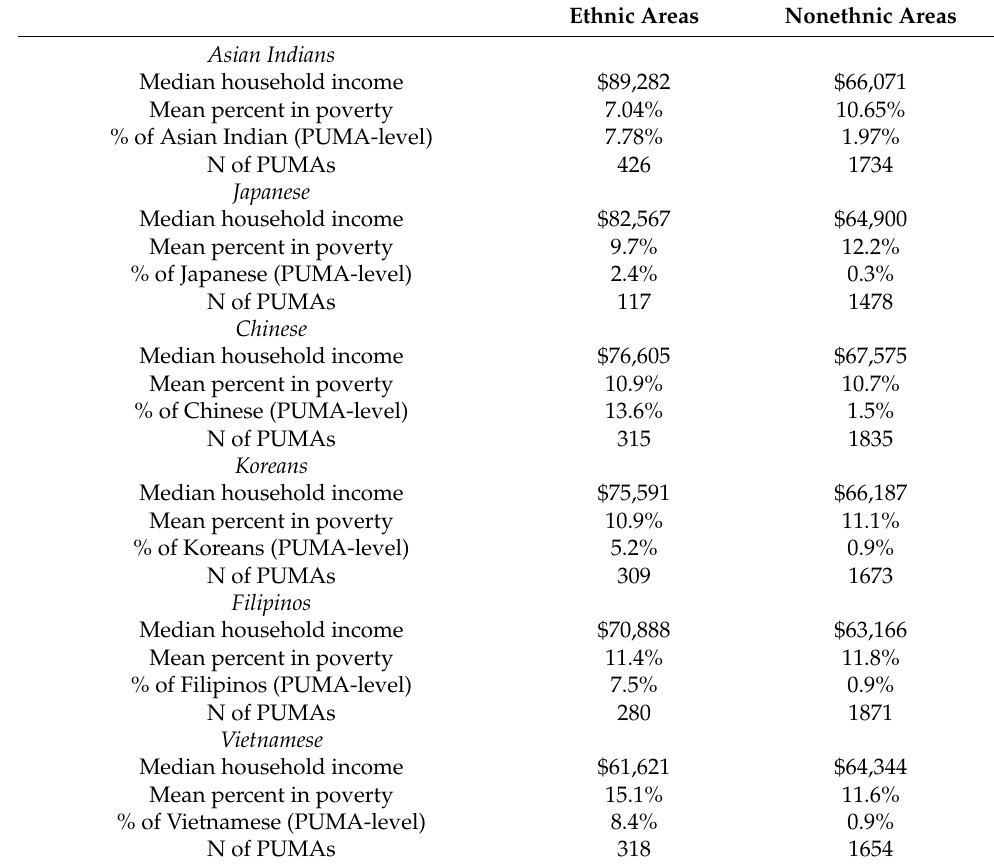
Table A1. Descriptive Statistics and Characteristics of Ethnic and Nonethnic Areas,